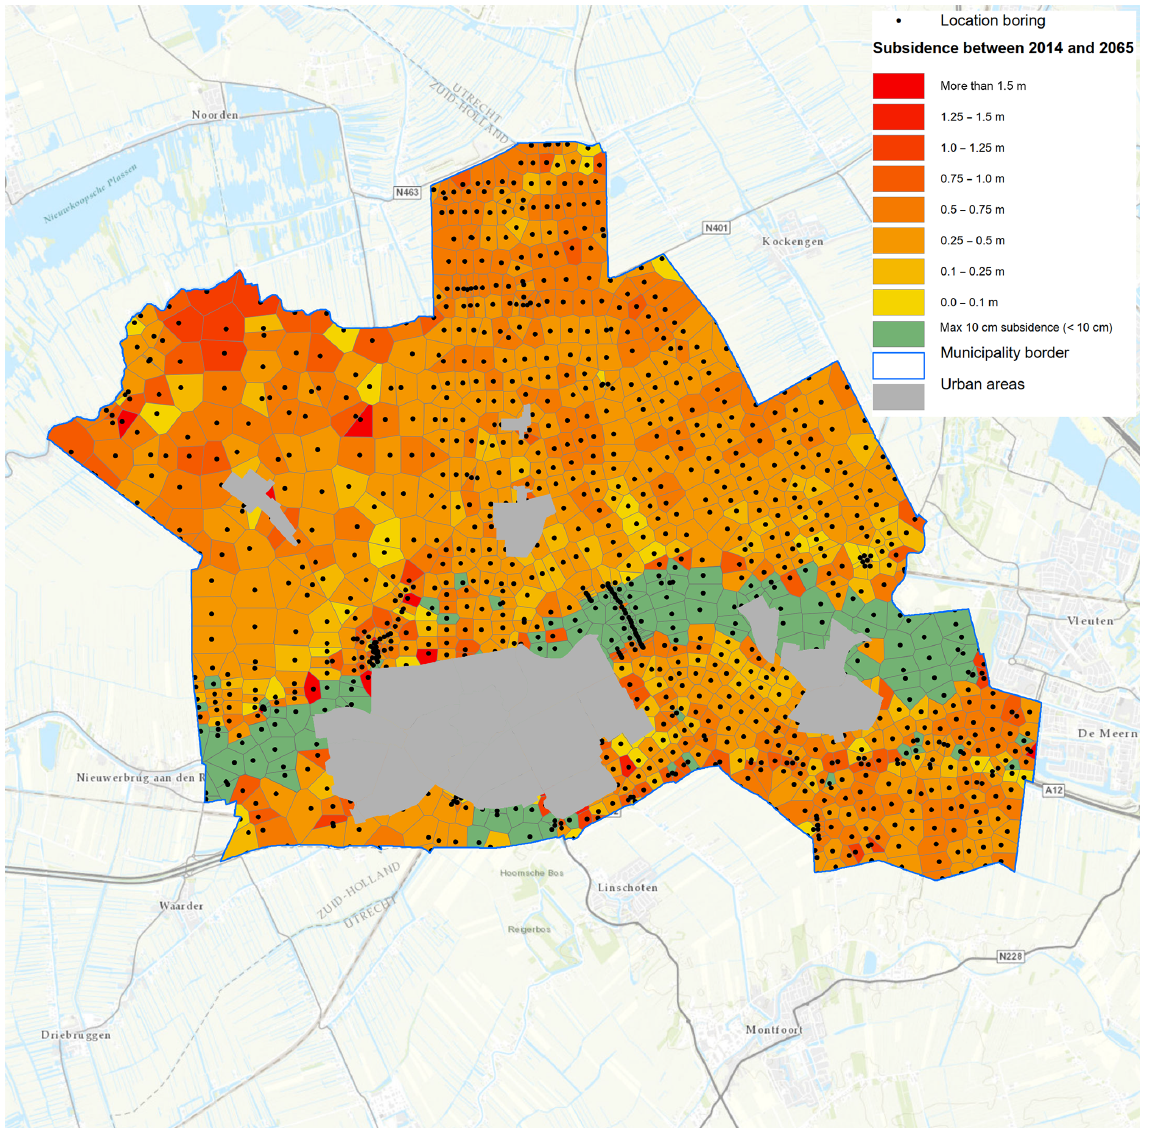
Figure 2. Visualisation of the calculation results using all available borings and the modified Phoenix model. Background: Esri Nederland & community maps